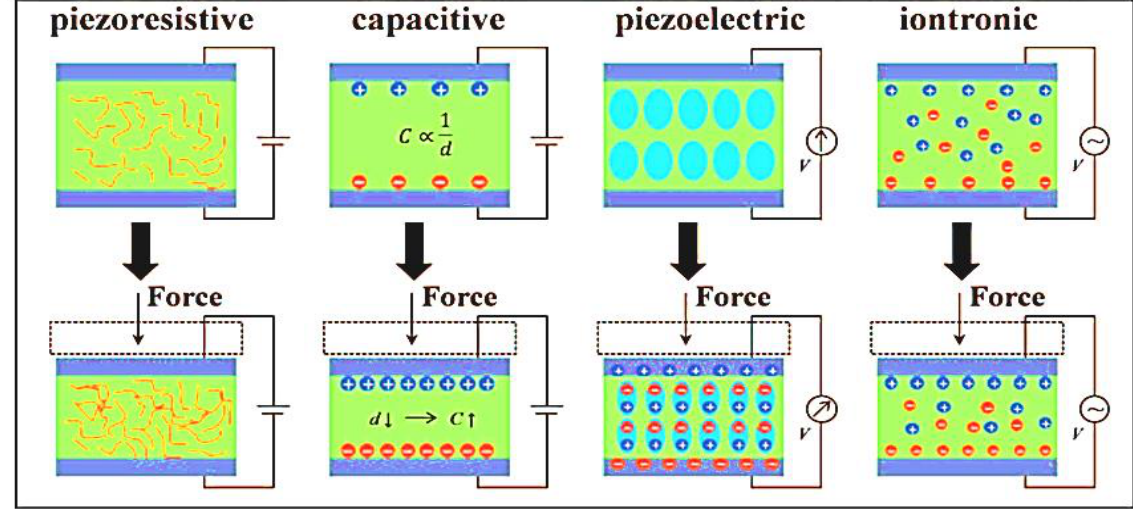
Figure 5. Illustration of different categories of electro-mechanical transduction mechanisms [39].